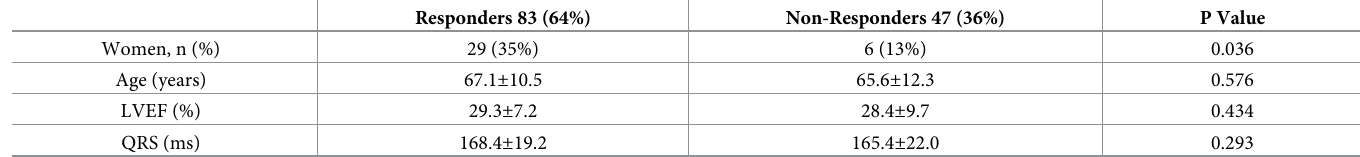
Table 2. Clinical